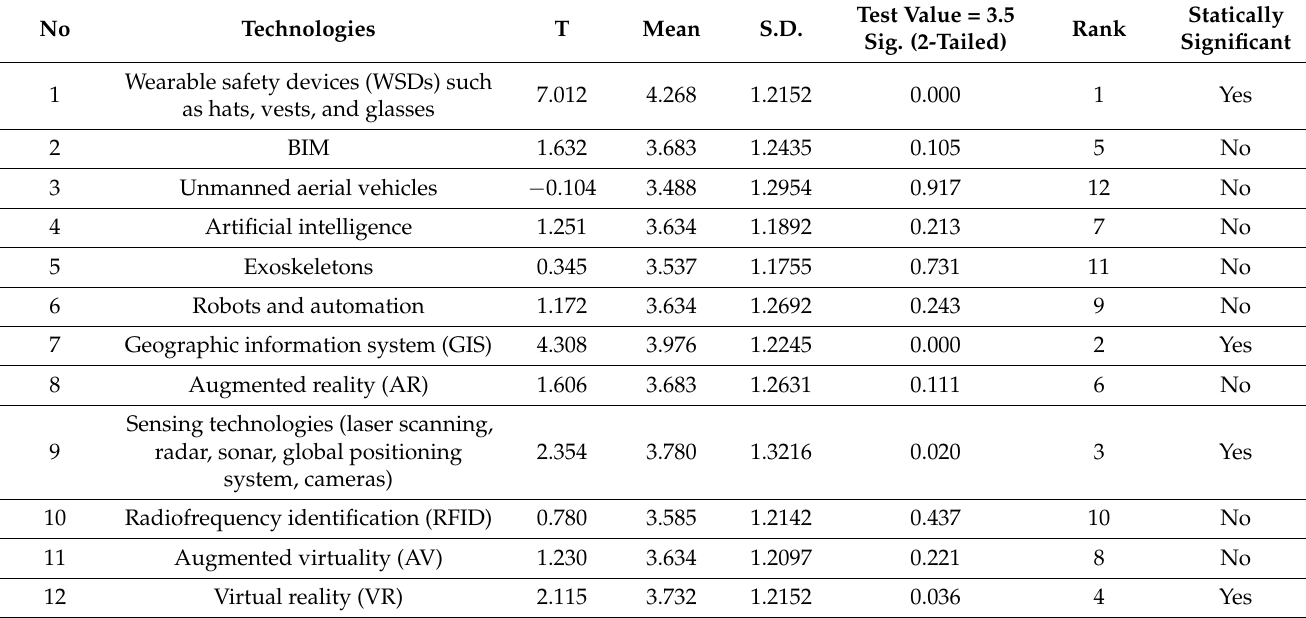
Table 2. A summary analysis of the current technologies important for health and safety in the Ghanaian construction